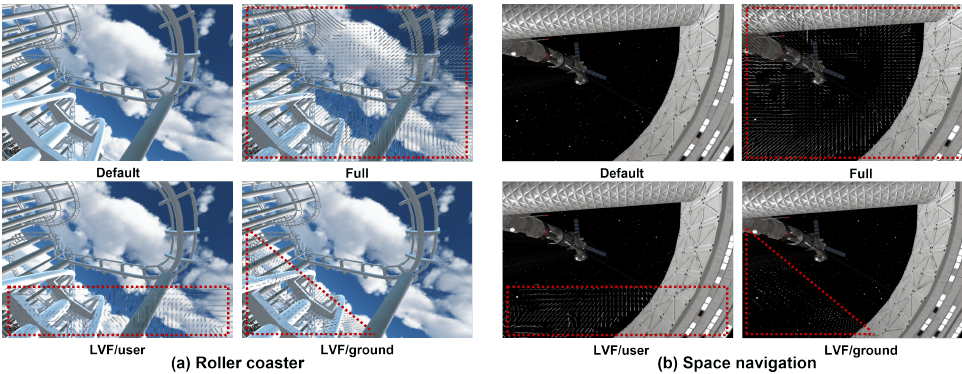
Figure 8. Scenes from the respective four conditions compared in the supplementary experiment: roller coaster ( left ) and space navigation ( right ). From left, default, full, LVR/user, and LVR/ground).